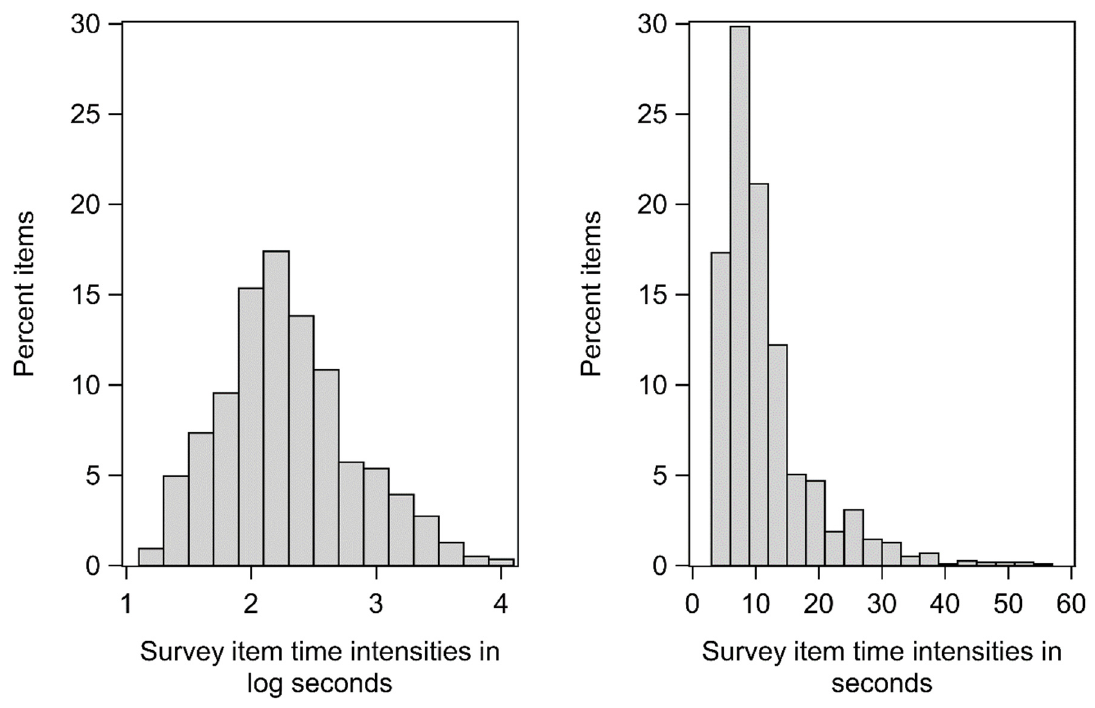
Figure 1. Distribution of time intensities of the survey items (n = 1173) in log seconds ( left ) and in seconds ( right ). Time intensities in log seconds were used in the analyses.